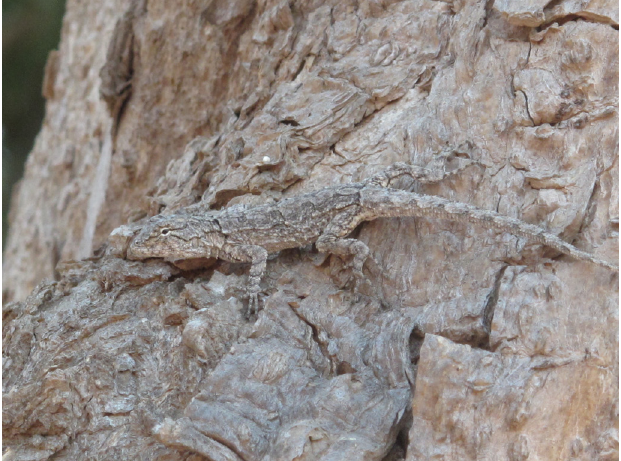
Urosaurus bicarinatus from Cocinas Island. Specimen (CIB 4291) perching at the base of a 2 m height cactus. Photo by U.